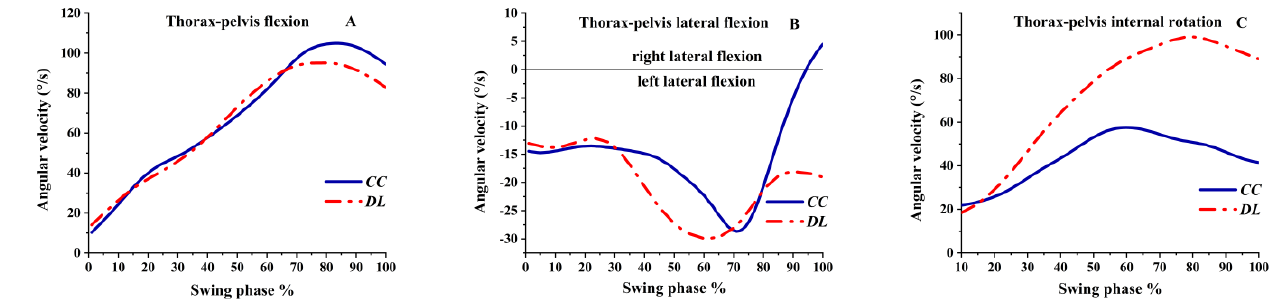
Figure 10. The angular velocity of the thorax–pelvis during the swing phase.